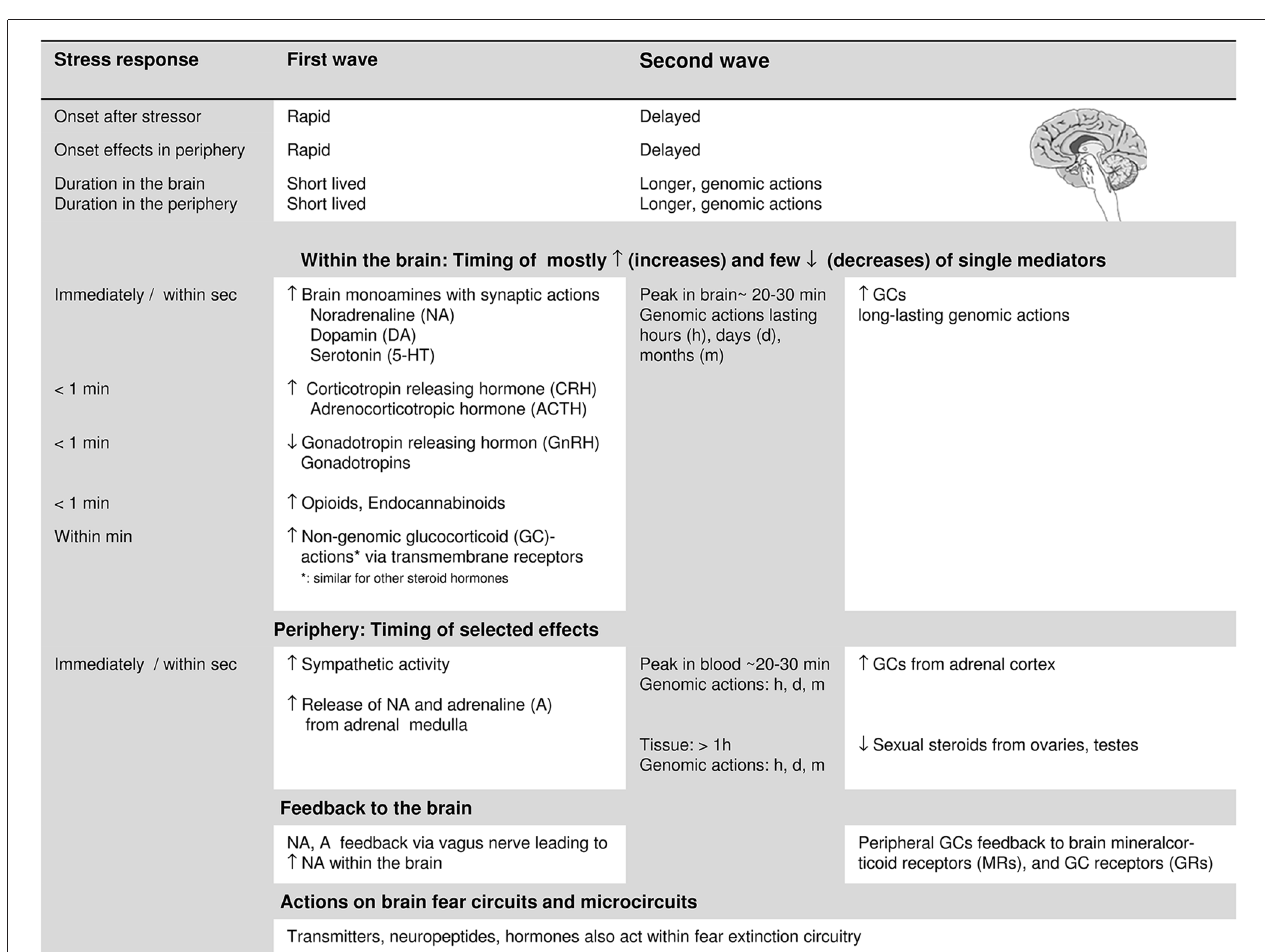
FIGURE 2 | Features of the rapid, first wave and the delayed second wave of the stress response: onset in brain and periphery and the timing of the activation of the mainly involved stress-response mediators (neurotransmitters, neuropeptides, hormones) . The concrete time specifications of the stress-induced changes are based on Sapolsky et al. (2000), Joëls and Baram (2009) and Hermans et al. (2014). For glucocorticoids (GCs) and sexual steroids, we differentiate between more rapid non-genomic, and delayed genomic actions. As to the stress-induced changes in the periphery, we only refer to the following, major changes: the rapid activation of the sympathetic nervous system and the corresponding rapid secretion of catecholamines, and to the increase in the secretion of GCs and the decrease in the secretion of sexual steroids from the adrenal cortex. The peripheral changes feedback to the brain and the single stress-response mediators also act on the fear extinction circuits and microcircuits (see “Contributions of specific stress mediators: insights from pharmacological manipulations, transmitter and neuropeptide actions” and “Insights from stress-induction studies triggering the first and second wave of the stress response” Sections). When referring to effects of single stress-response mediators on fear extinction within the text, we also take neuropeptide Y and oxytocin into account due to their role in stress resilience and their impact on fear extinction. The bodily reactions allowing adaptation to the stress challenge are not explicitly addressed in this